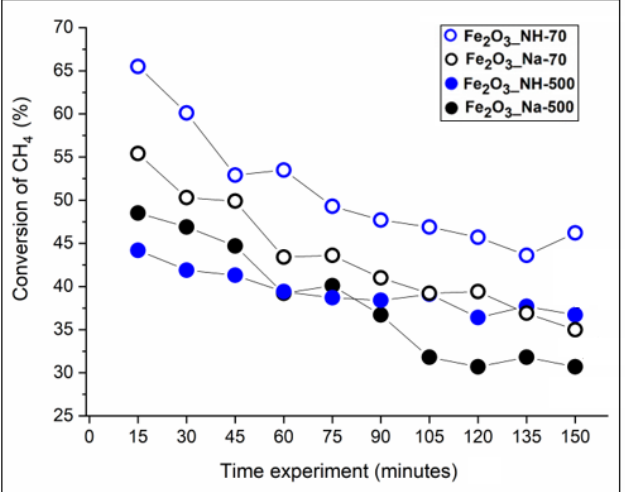
Figure 11. Time conversion of CH 4 at the presence of NPs precipitated at 70 °C and calcined at 500 °C.